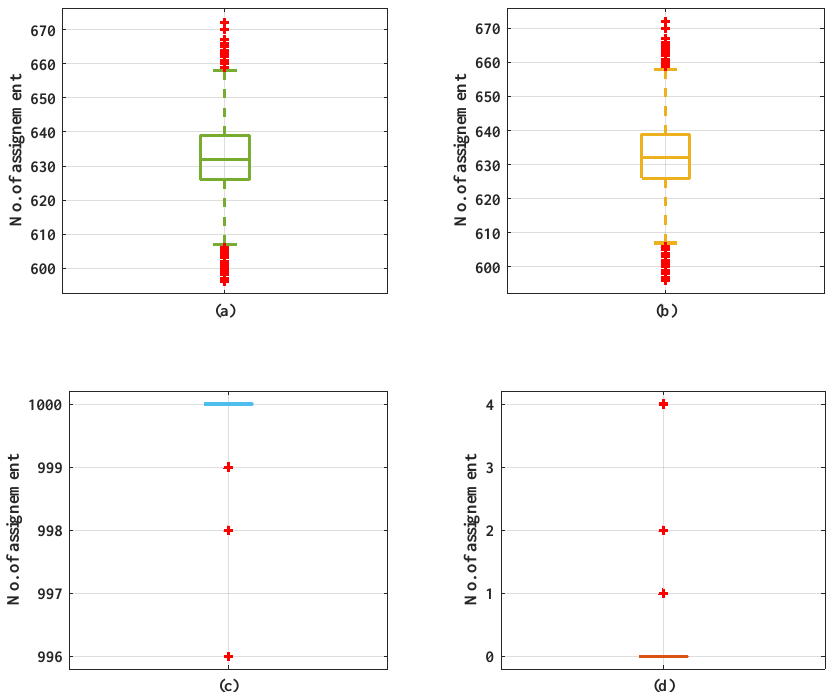
Figure 11. The number of assignment statistics in the case of 1000 nodes. ( a ) Number of assign- ment statistics after column reduction; ( b ) Number of assignment statistics after reduction transfer; ( c ) Number of assignment statistics after augmenting reduction; ( d ) Number of assignment statistics after augmenting